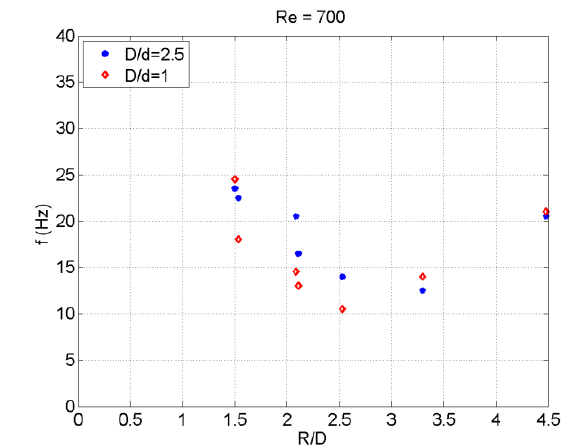
Figure 4. Relationship between the frequency and the pitch distance for Re 700